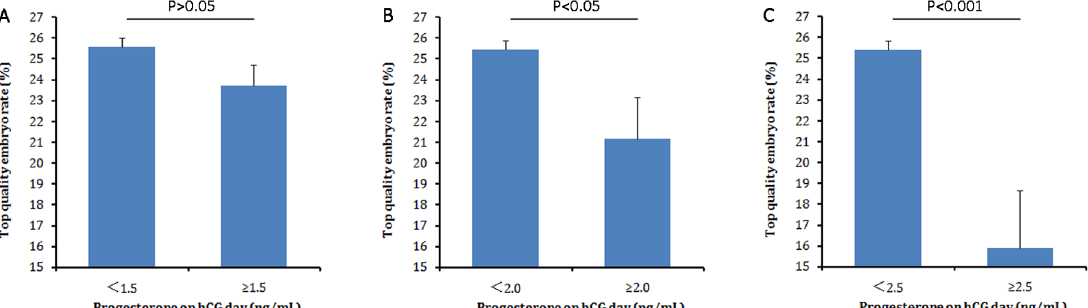
Fig 2. Top quality embryo rate according to different serum progesterone concentration cut-point on the day of hCG administration. (A) progesterone cut-point, 1.5 ng/mL; (B) progesterone cut-point, 2.0 ng/mL; (C) progesterone cut-point, 2.5 ng/mL. The TQE rate was significantly different ( P < 0.05) between serum progesterone levels < 2.0 ng/ml and > 2.0